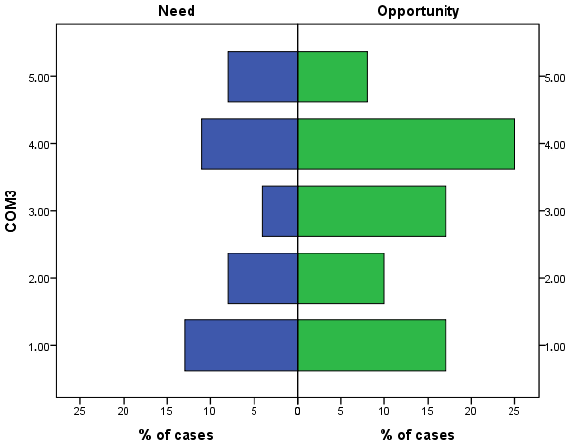
Figure 8. Barplot of COM3 (efficient co-operation with other actors of the ecosystem) split per need and opportunity.